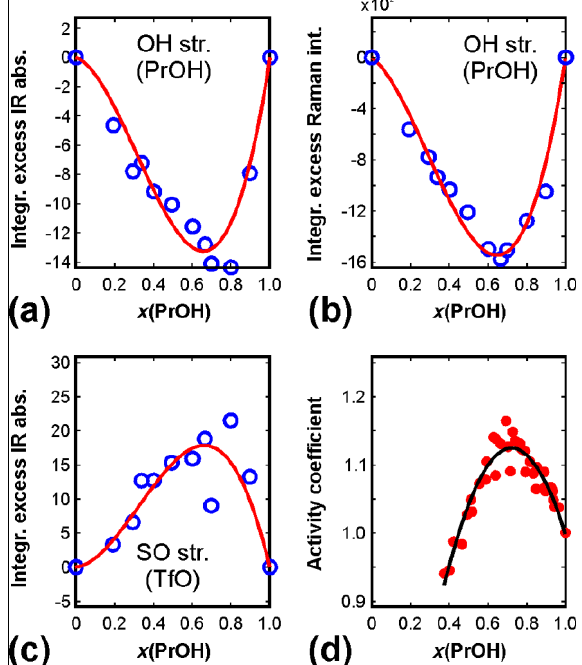
Figure 4. Panels ( a–c ) show the integrated excess absorbance/intensity as a function of the propanol mole fraction for selected spectral signatures. For this purpose, the band areas over characteristic spectral windows in the excess spectra were calculated. Panel ( d ) shows the profile of the activity coefficient derived from vapor–liquid equilibrium (VLE) data [11] for comparison.